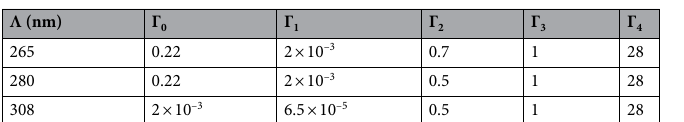
Table 2. The values used to obtain the theoretically fitted curves shown in Fig. 2a,b,c, derived from Eqs. (1) and (2). Here, Γ 0 (cm 2 /mJ) is the rate of UV radiation directly causing DNA damage by the formation of thymine dimers; Γ 1 (cm 3 /s) is the rate of ROS radicals causing damage to DNA; Γ 2 (cm 2 /mJ) is the rate of generation of ROS radicals at bacteria by UV radiation; Γ 3 (1/s) is the lifetime of ROS radicals; and Γ 4 (cm 3 /s) is the mutual destruction rate of ROS radicals.